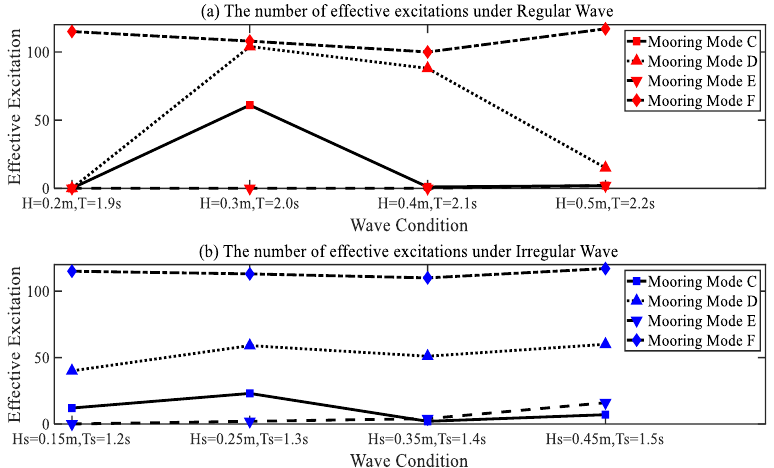
Figure 16. The total number of effective excitations for the buoy under different wave conditions in the two-anchor line mooring mode. the two-anchor line mooring